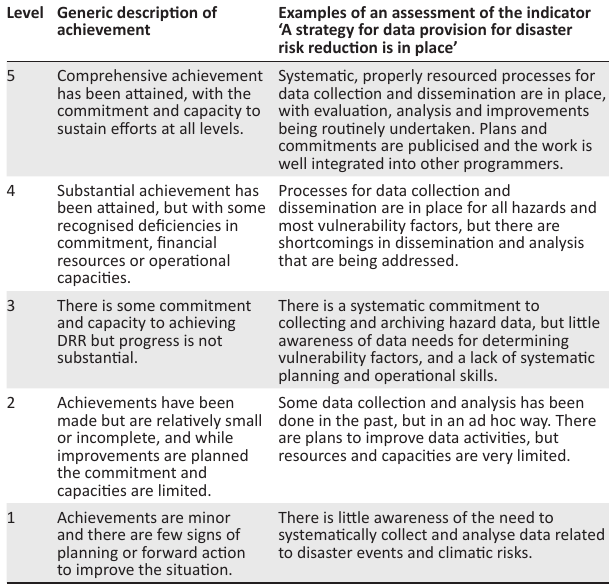
TABLE 5: Five-level assessment tool for use in grading achievement of qualitative factors in indicators.